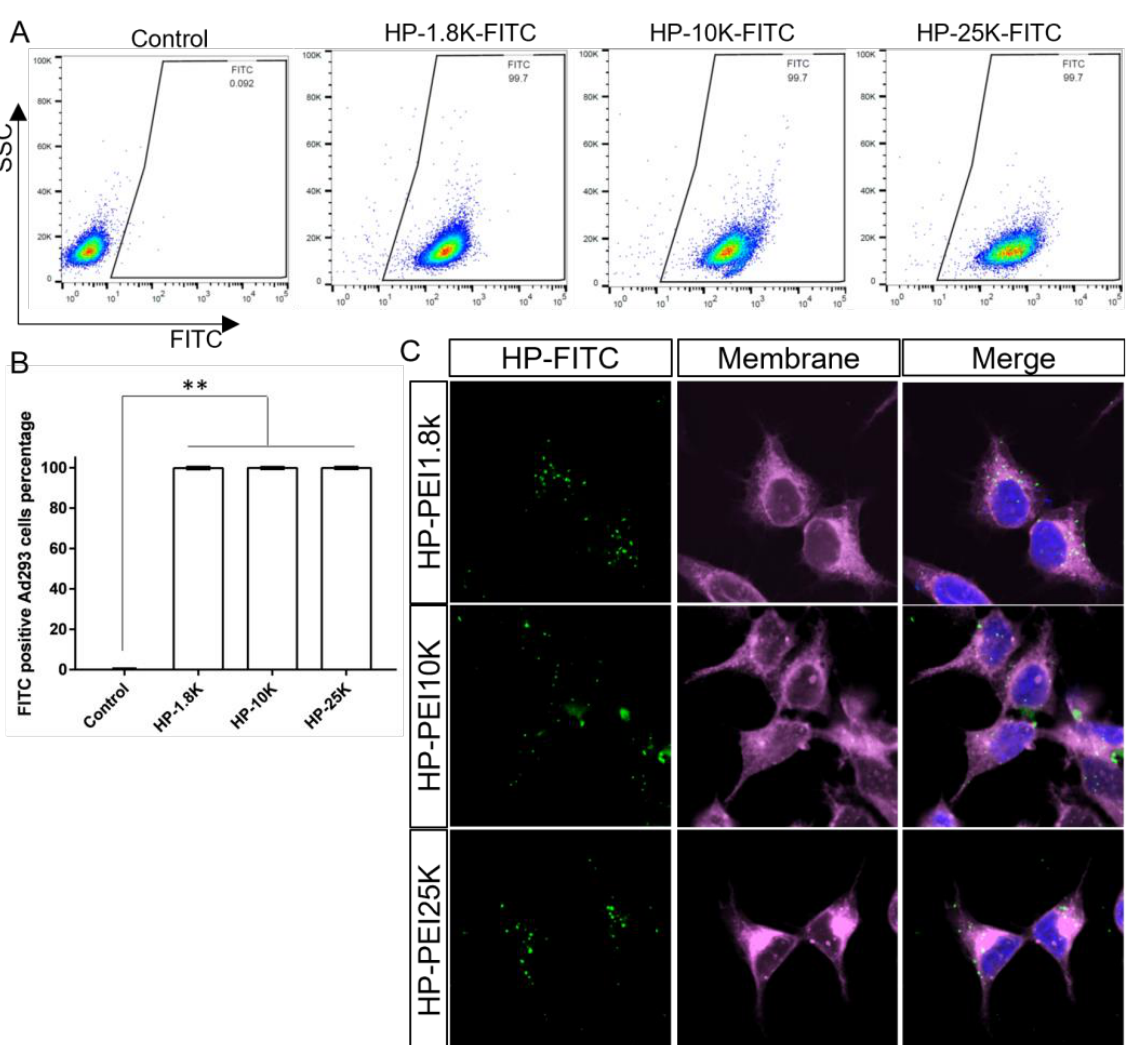
Figure 2. HP nanoparticles enter cells efficiently. ( A ) Representative flow cytometry results of Ad293 cells treated with FITC labeled HP nanoparticles. ( B ) Quantitative summary of flow cytometry results. ( C ) Confocal microscopy images of Ad293 cells treated with FITC labeled HP nanoparticles. Green: FITC labeled HP nanoparticles. Purple: membranes. Blue: nuclei. ** p < 0.01.